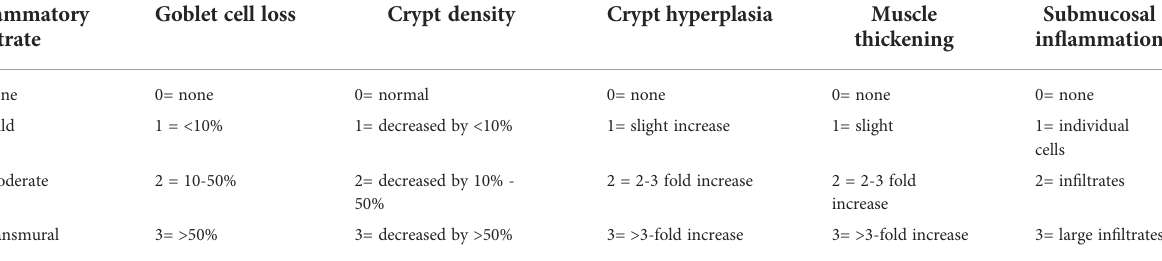
TABLE 2 Histology scoring of T-cell transfer